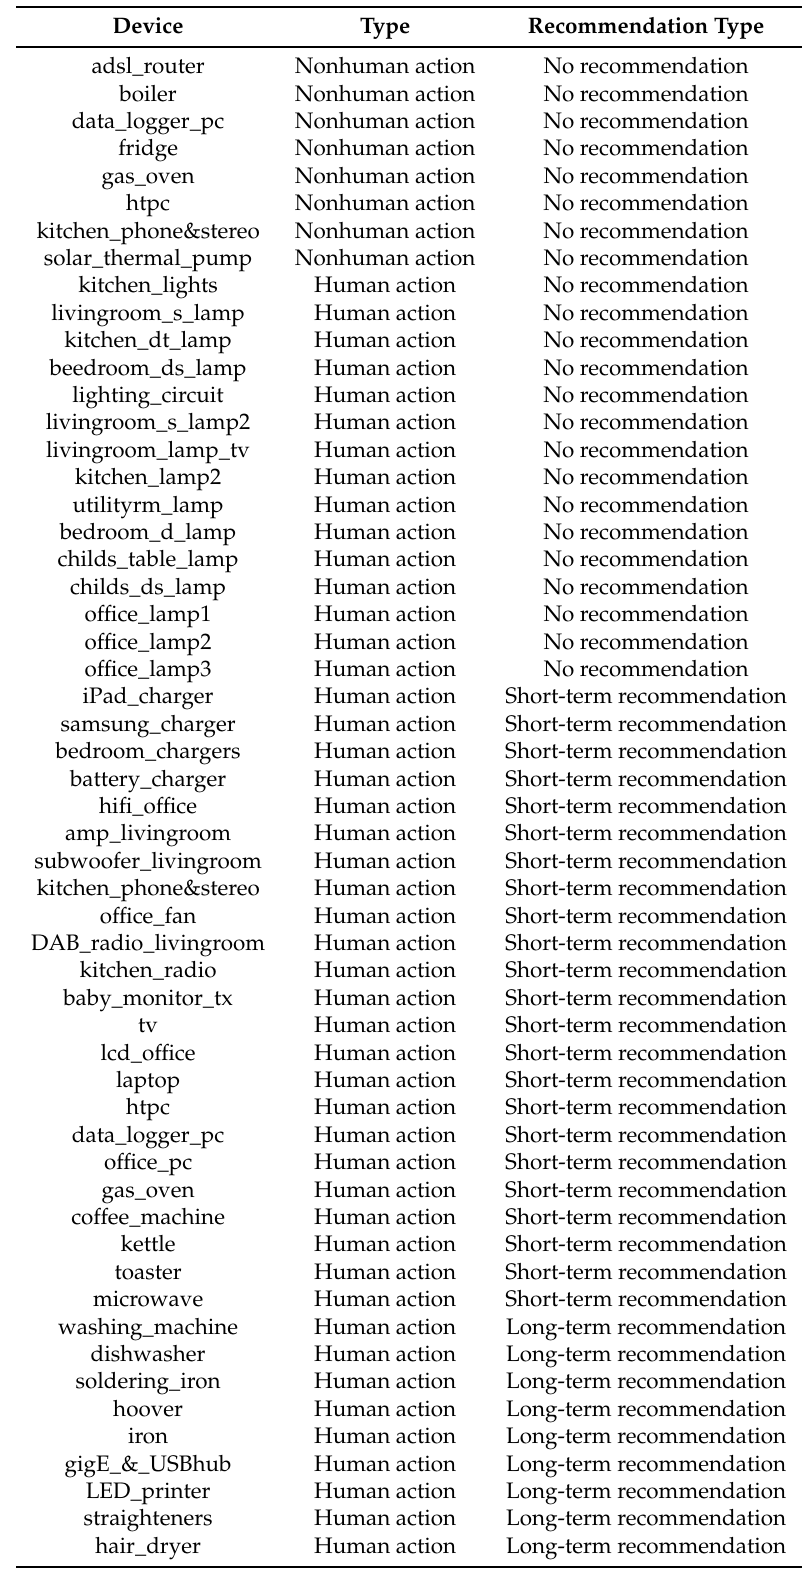
Table 2. Devices used in the case study and their